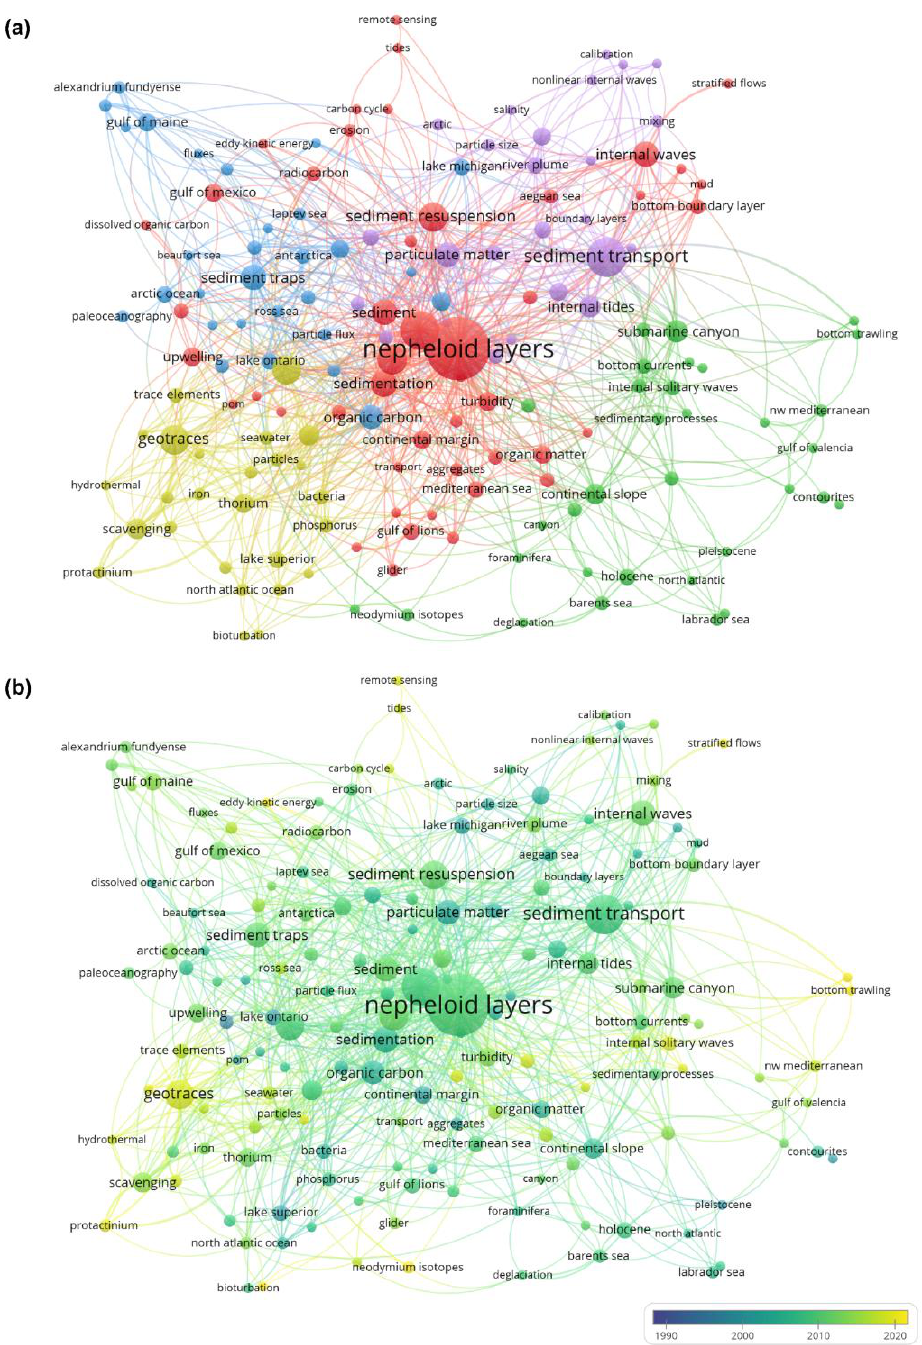
Figure 7. Keyword co-occurrence analysis for nepheloid layer research from 1990 to 2022. ( a ) Co- occurrence network of keywords. Different clusters can be identified by their nodes’ colors. ( b ) Time distribution of keyword co-occurrence network. The brighter yellow color on a node indicates a later keyword appearance, while the darker purple color on a node suggests an earlier keyword appearance. The size of the node represents the frequency of keywords.